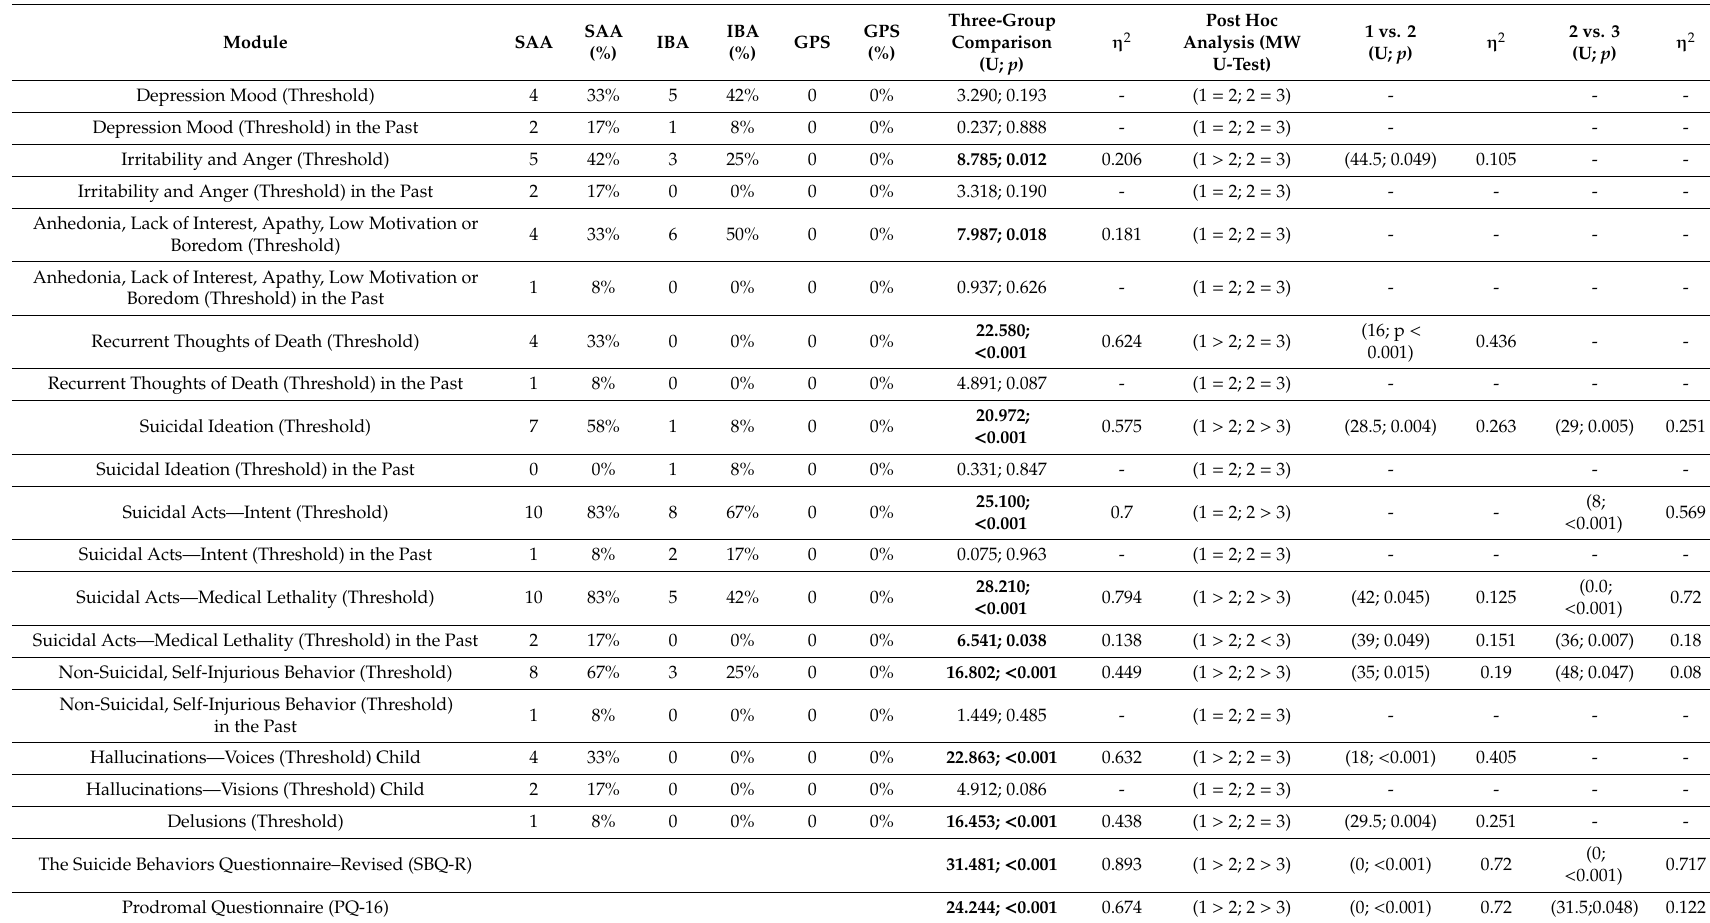
Table 3. Group comparisons for the Kiddie Schedule for A ff ective Disorders and Schizophrenia (K-SADS)